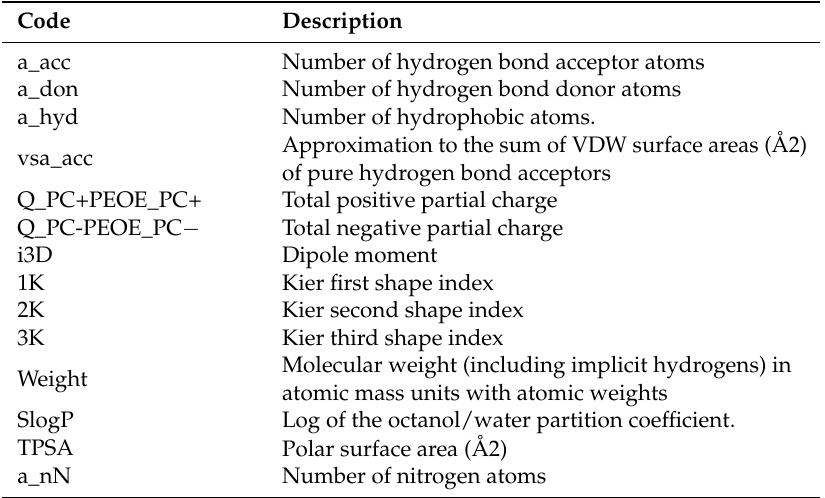
Table 5. Molecular Descriptors Calculated with